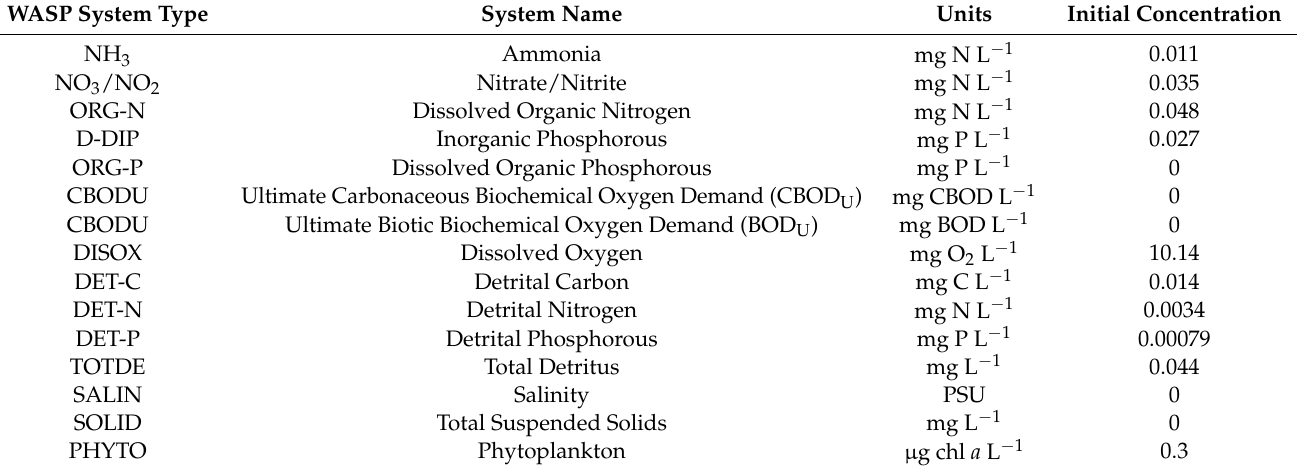
Table 1. System state